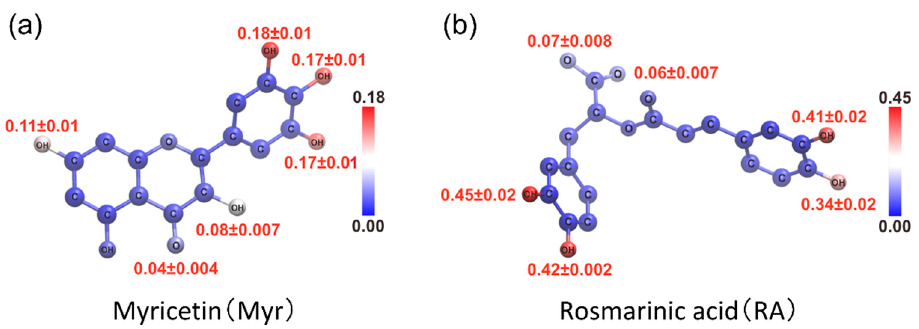
Figure 9. Color mapping to show contact probability of the ( a ) Myr and ( b ) RA atoms with the A β (16–22) peptide at 300 K. Reprinted with permission from Ref. [31]. Copyright 2020 Elsevier.